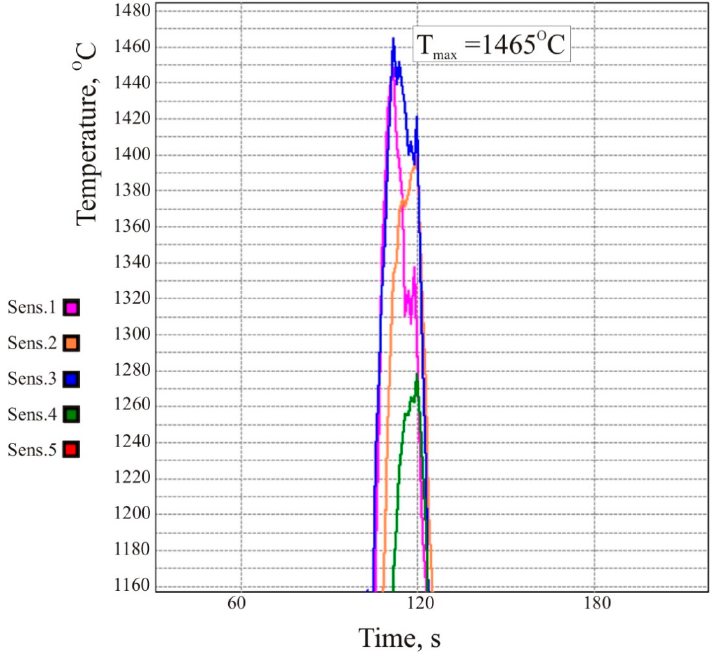
Figure 12. Thermogram recorded by thermocouples placed in silicon carbide inserts with a protective SiC coating.